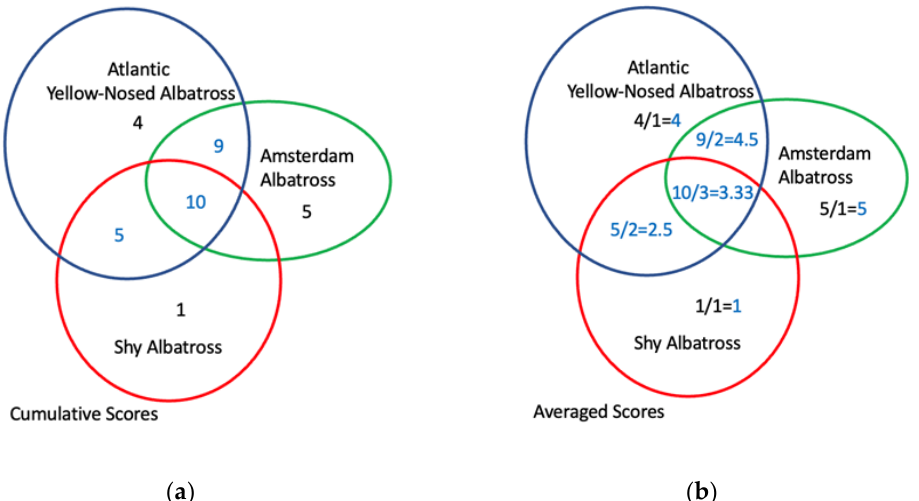
Figure 2 . An example of assigning risk scores to grid cells for overlapping areas of albatross at-sea ranges. ( a ) Cumulative Albatross IUCN Red List Scores by Grid Cell; ( b ) Average Albatross IUCN Red List Scores by Grid Cell. The scores were calculated by summing the IUCN Red List status scores (0 – 5) of the albatross species whose at-sea ranges overlap with a given grid cell divided by the number of albatross species found within these grid cells.